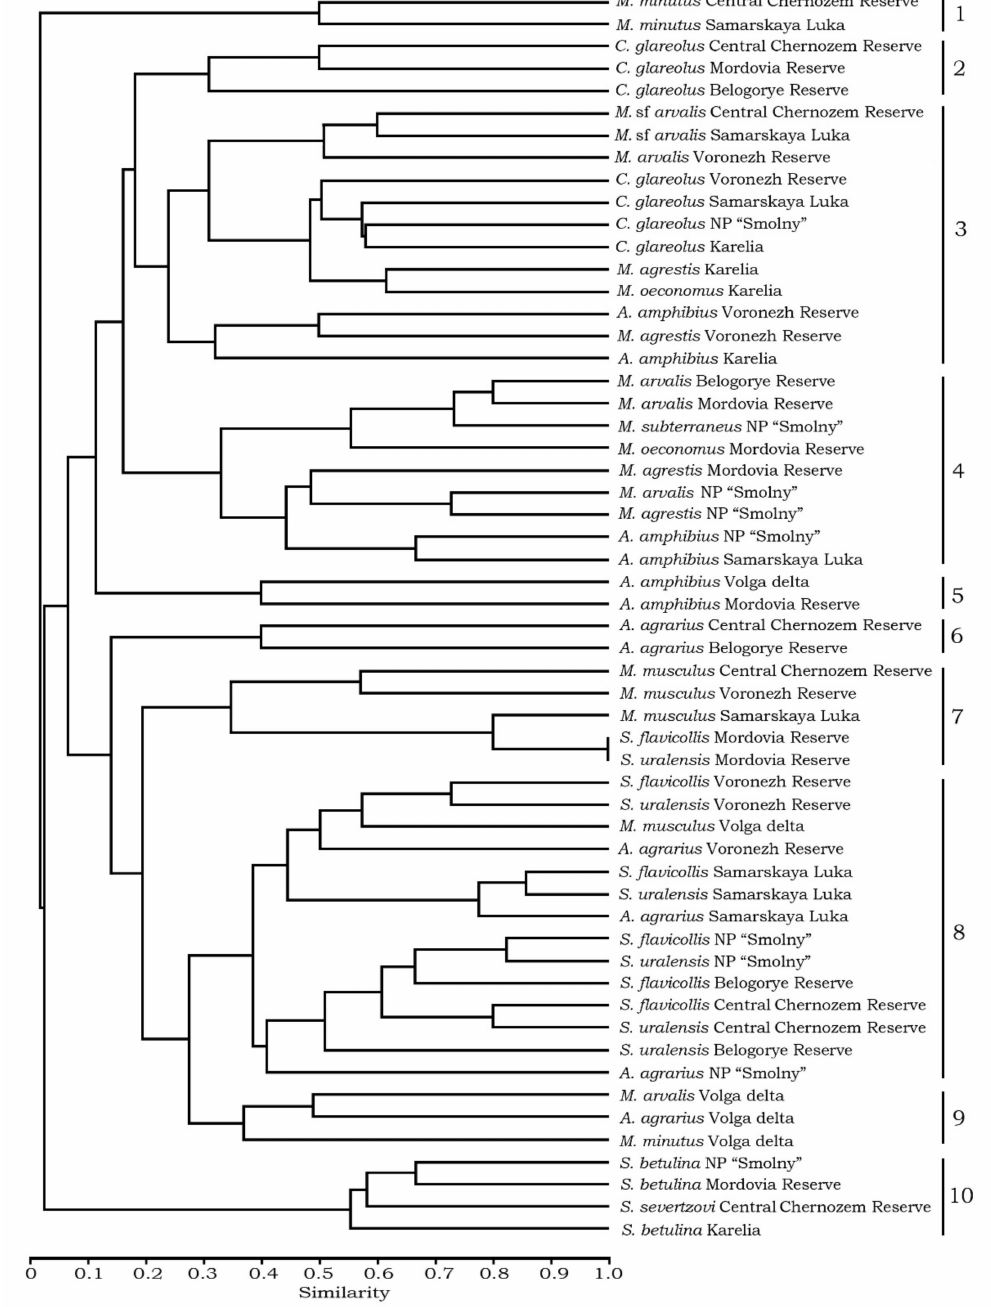
Figure 2. Similarity dendrogram of the helminth fauna in myomorph rodents from different regions of European Russia, obtained by the Morisita index (UPGMA). Correlation Coefficient: r = 0.811. The fourth group is divided into two subgroups. The first subgroup is formed by the helminth fauna in M. arvalis from the Belogorye Nature Reserve and Mordovia Nature Reserve and the parasite fauna in M. subterraneus from the National Park “Smolny”. The helminth fauna in M. oeconomus from the Mordovia Nature Reserve is adjacent to this subgroup. The second subgroup includes the helminth fauna in M. agrestis from the Mordovia Nature Reserve, M. arvalis and M. agrestis from the National Park